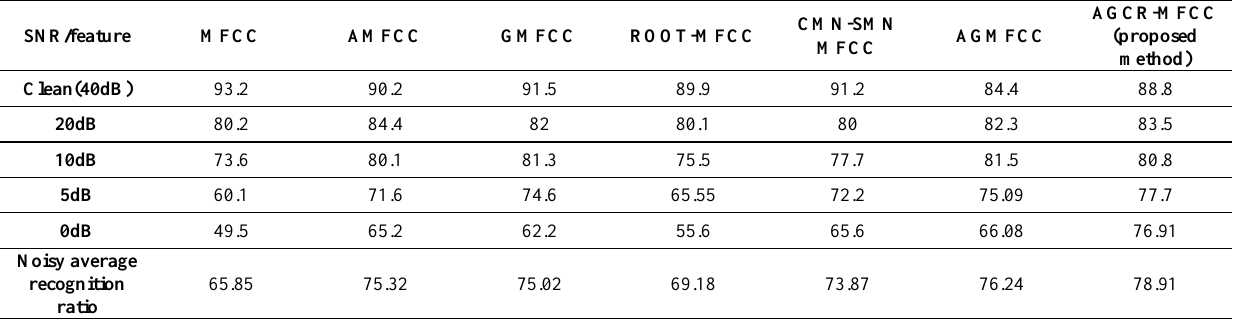
Table 3. The entire training and testing data was used for experiments. Results for AGCR-MFCC show improvement in comparison with other traditional method in recognition rate when artificial white Gaussian additive noise increase. Noisy average recognition ratio proves that proposed method is more robust to noise than traditional